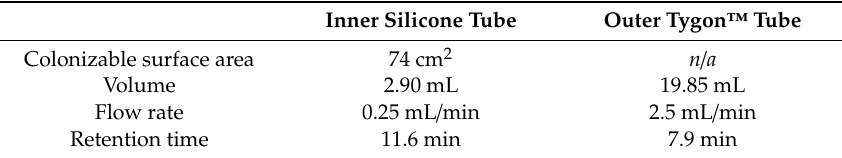
Table 1. CO 2 sequestration monitoring system (CSMS) properties and operating conditions.